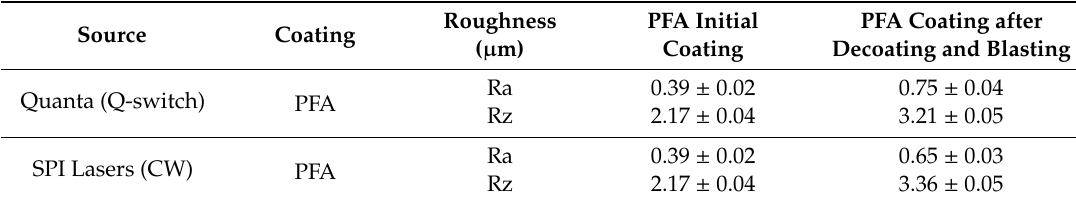
Table 4. Roughness values of PFA coatings applied on EN-AW5754 substrates before and after